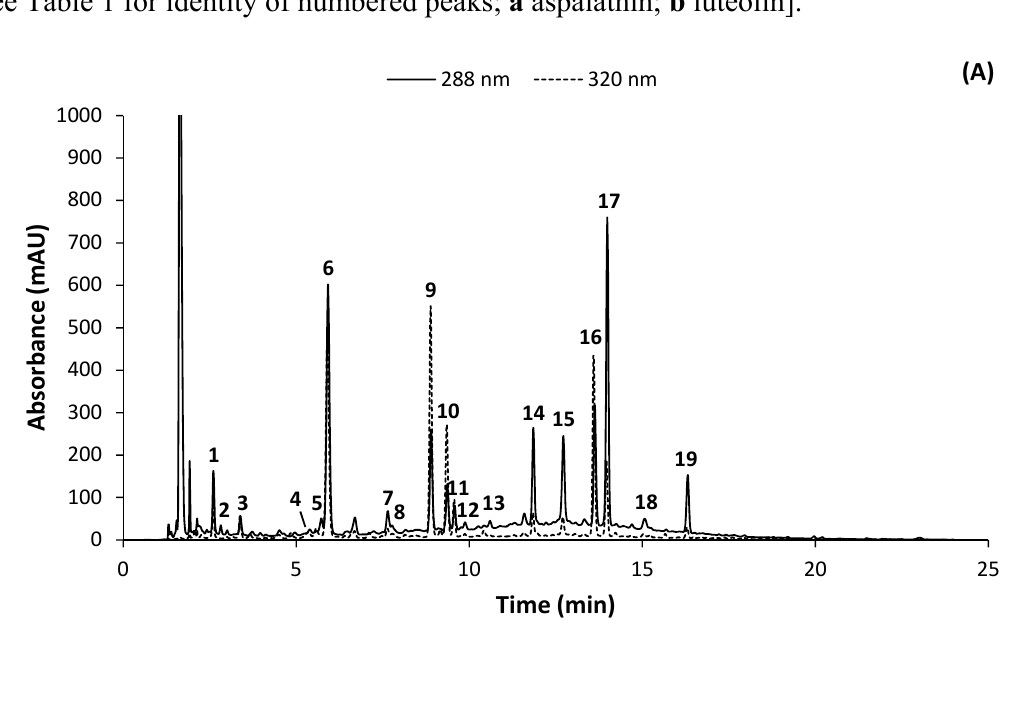
Figure 1. Chromatograms showing ( A ) phenolic compounds identified in freeze-dried aqueous extracts of green Cyclopia subternata and ( B ) a standard calibration mixture [see Table 1 for identity of numbered peaks; a aspalathin; b